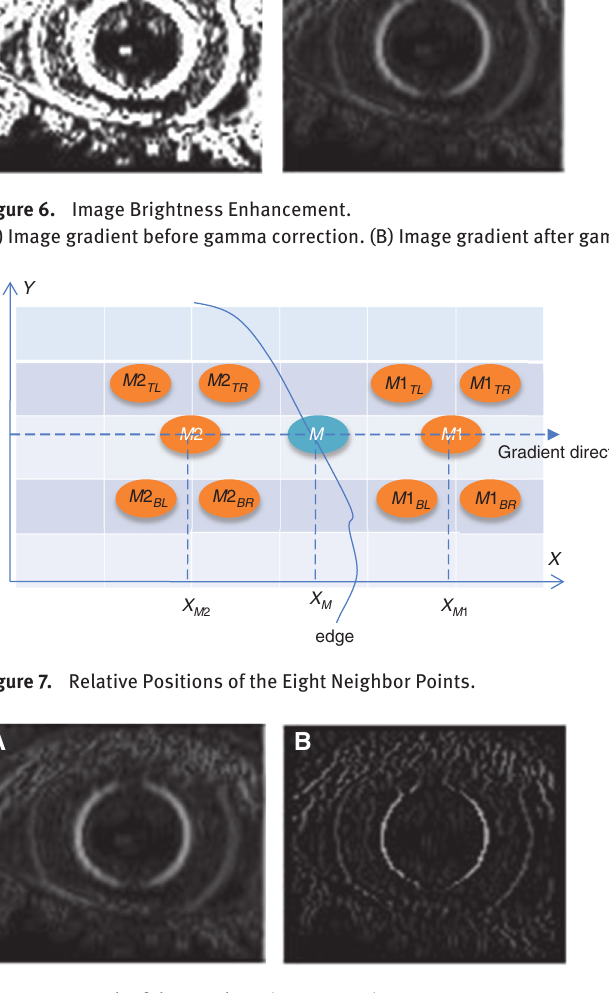
Figure 8. Result of the Local Maxima Preserving Process. (A) Image after the correction of the contrast. (B) Result of the local maxima preserving